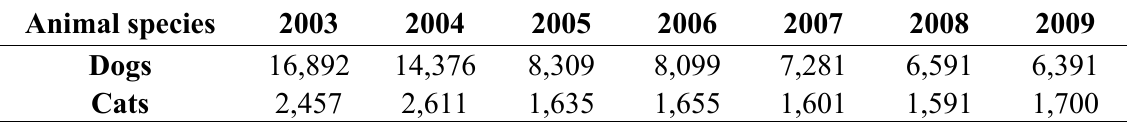
Table 1. Annual number of imported and quarantined dogs and cats. The numerical data show the number of animals.